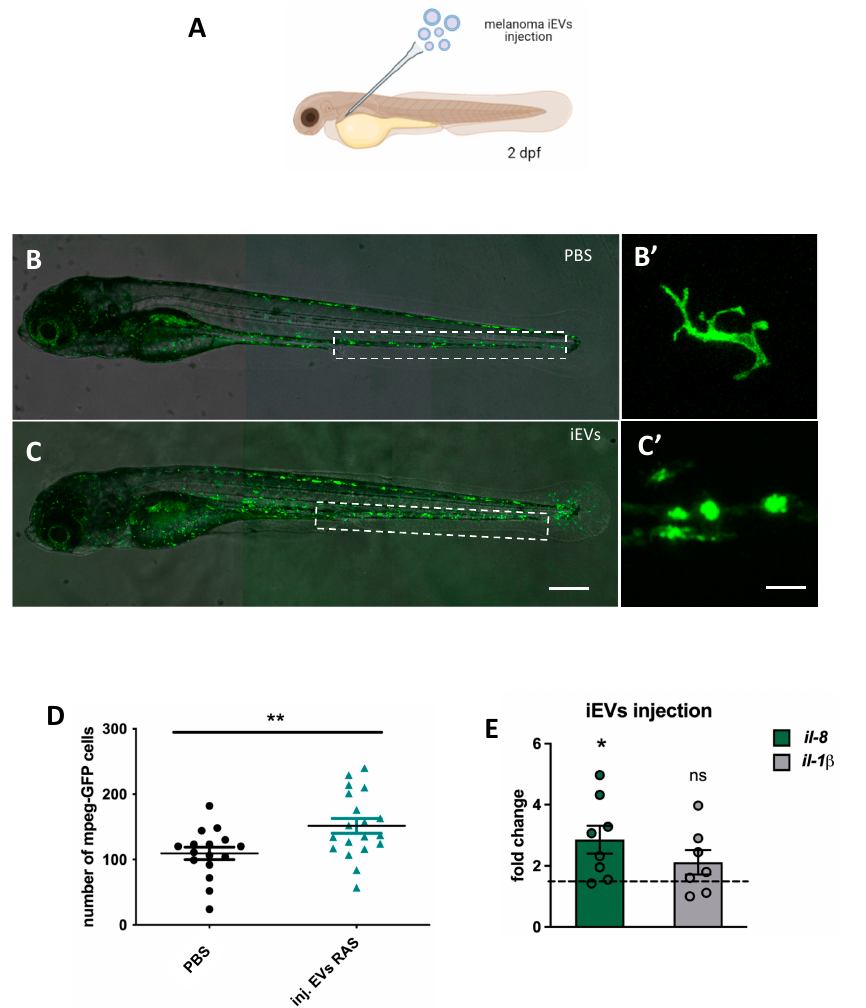
Figure 5. Intravascular injection of iEVs induce an inflammatory response. ( A ) Schematic representation of the experimental procedure for intravascular injection of melanoma iEVs (drawing realized with BioRender). ( B , C ) Fluorescence stereomicroscope images of 5 dpf tg(mpeg:GFP) gl222 larvae injected intravascularly with PBS or with melanoma iEVs at 2dpf, as indicated. The caudal hematopoietic tissue (CHT), where counts were performed, is boxed. ( B’ , C’ ) High magnification images of macrophages in the injected tg(mpeg:GFP) gl222 showing differences in shape in the two conditions. ( D ) Counts of macrophages in the CHT of injected larvae. ( E ) QPCR analysis of the expression of two inflammatory cytokines in iEV-injected larvae compared to PBS-injected (horizontal dashed line). * p < 0.05; ** p < 0.01. Scale bars: 100 μ m. ns: not significant.